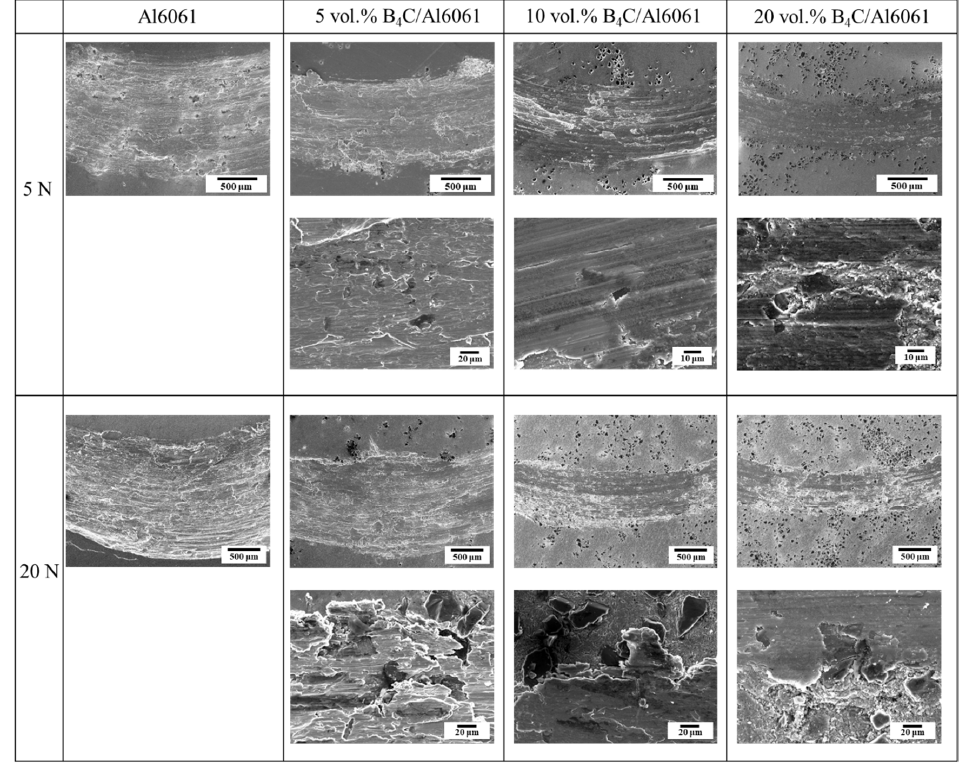
Figure 5. Worn surface SEM images of Al6061, 5 vol.%, 10 vol.%, and 20 vol.% B 4 C/Al6061 composites after wear tests at 5 and 20 N loads.